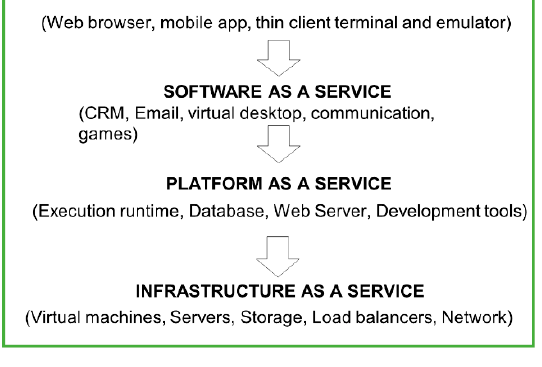
Figure 1. Cloud clients.